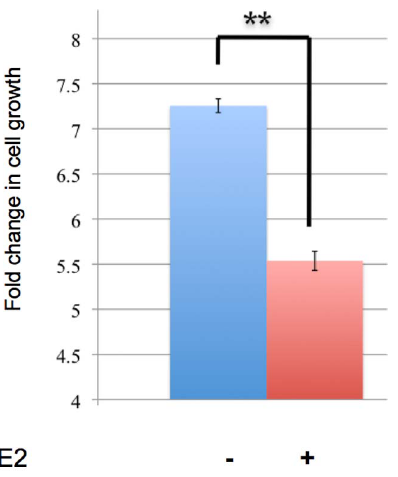
Figure 5. ER b negatively regulates cell proliferation in an E2 dependent-manner. C4–12/Flag.ER b cells were treated with 10 nM E2 for 3 days. Cell confluency, detected by the Incucyte FLR live content imaging system (Essen Bioscience), was used to measure cell proliferation. Bar graph represents fold change relative to day 0. (Error bar=standard